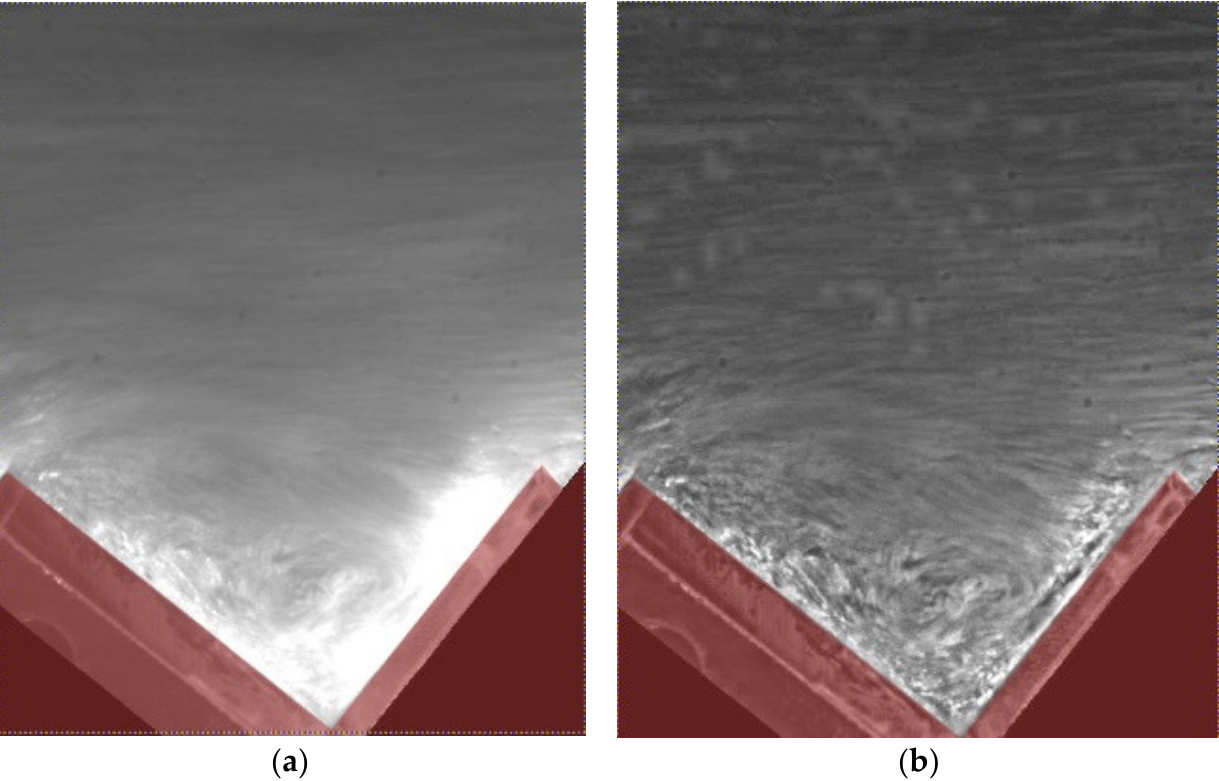
/ℎ = 2.38 and 200 fps. ( a ) Original image. ( b ) Image after Figure 7. Frame 1104 corresponding to  Figure 7. Frame 1104 corresponding to d c / h = 2.38 and 200 fps. ( a ) Original image. ( b ) Image after a  CLAHE filter and contrast improvement (minimum 0 and maximum a CLAHE filter and contrast improvement (minimum 0 and maximum 0.95).